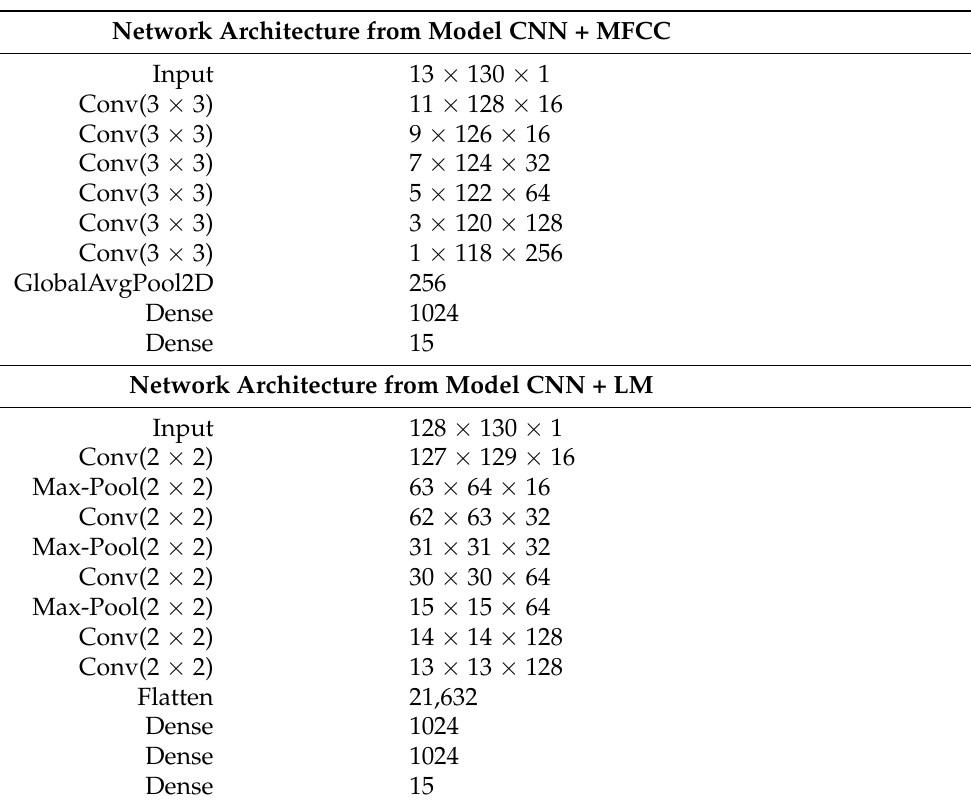
Figure 3. Example of raw audio signals at 44.1 kHz, log-Mel spectrogram (LM), and Mel-frequency cepstral coefficient (MFCC) of the ambient audio events: cutlery, blind, alarm clock, and door bell. Table 1. Network Architecture from models CNN + MFCC and CNN +